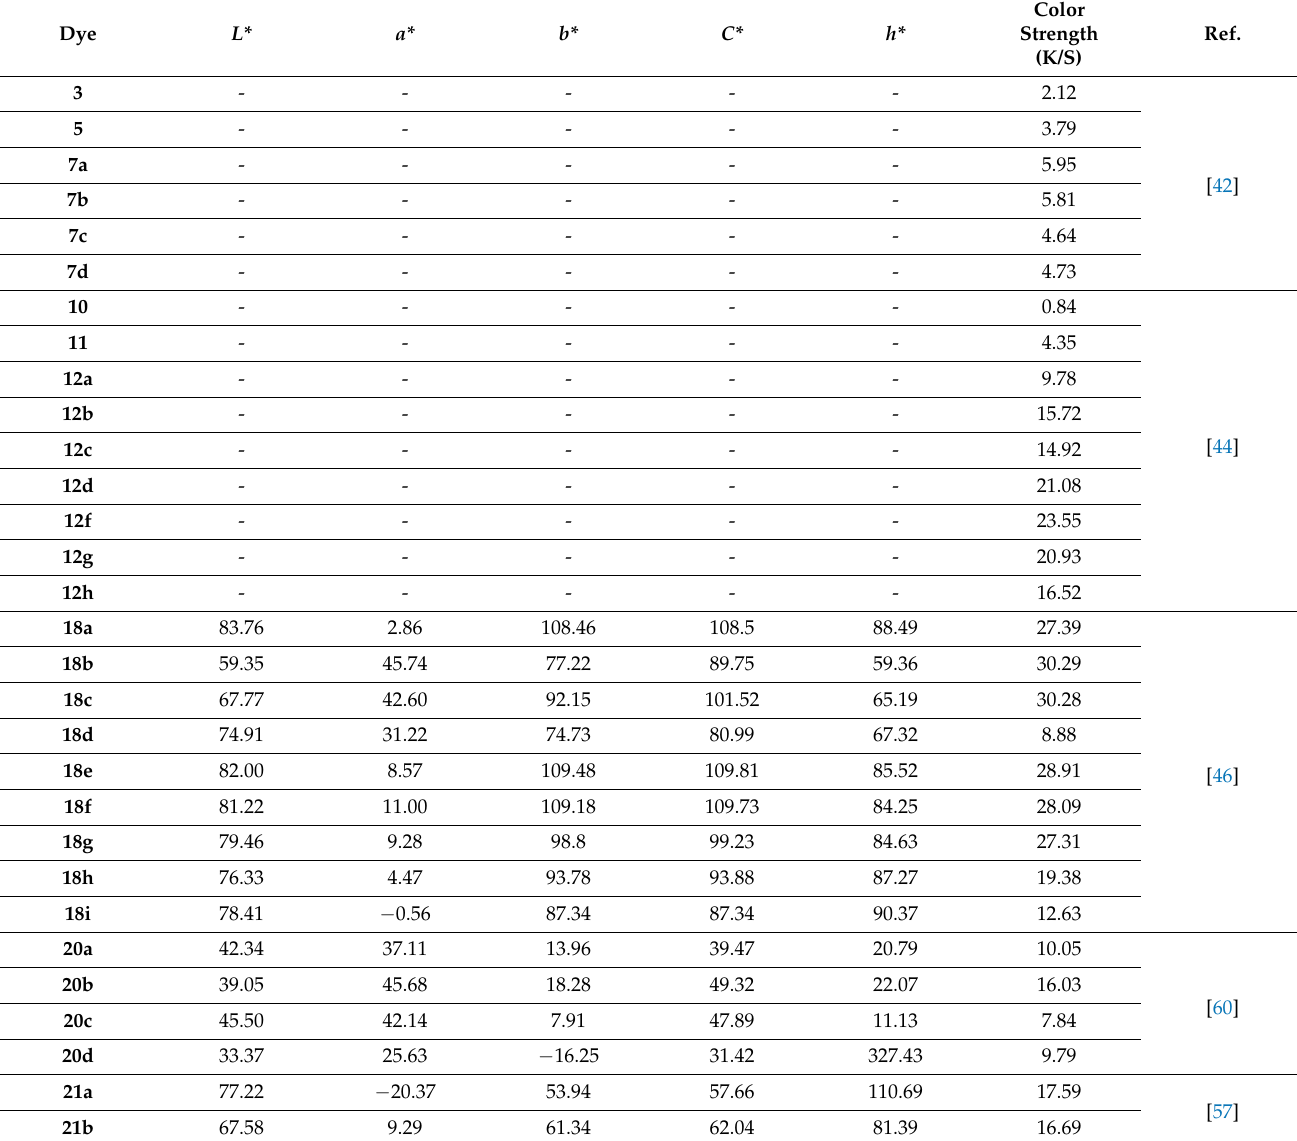
Table 1. K/S of polyester fabrics dyed with synthesized dyes at 130 ◦